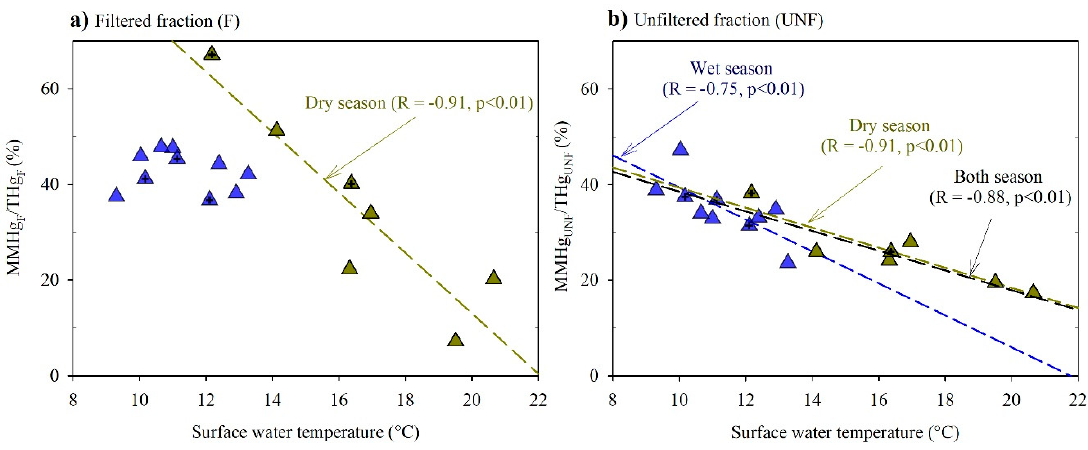
Figure 5. Plots of percentage MMHg/THg in ( a ) the filtered and ( b ) the unfiltered phases vs. surface water temperature. Crossed symbols indicate samples collected during the night-time period.